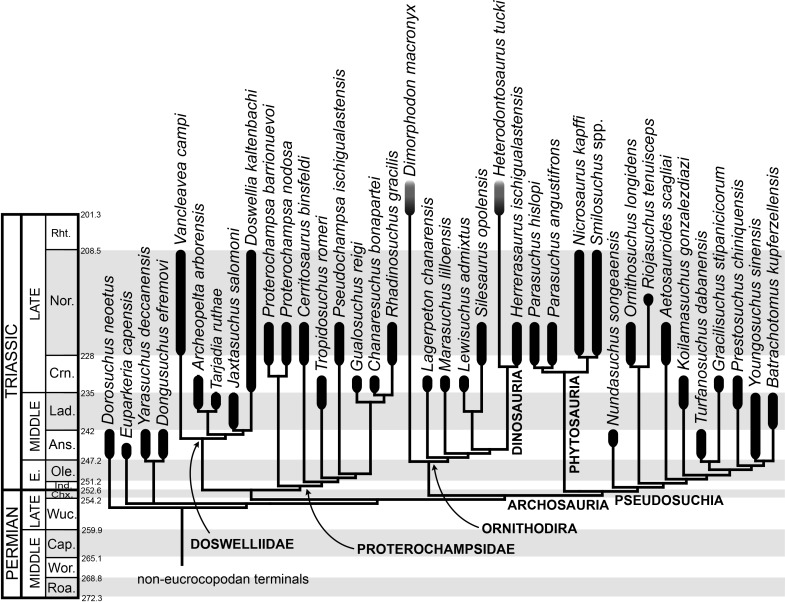
Time-calibrated phylogenetic tree of eucrocopodan archosauromorphs recovered in this analysis.Non-eucrocopodan archosauromorphs are not shown in this tree. The length of the vertical bar representing each terminal taxon represents chronostratigraphical uncertainty rather than true stratigraphical range. Abbreviations: Ans, Anisian; Cap, Capitanian; Chx, Changhsingian; Crn, Carnian; E., Early; Ind, Induan; Lad, Ladinian; Nor, Norian; Ole, Olenekian; Rht, Rhaetian; Roa, Roadian; Wor, Wordian; Wuc, Wuchiapingian. Geological timescale after Gradstein et al. (2012).